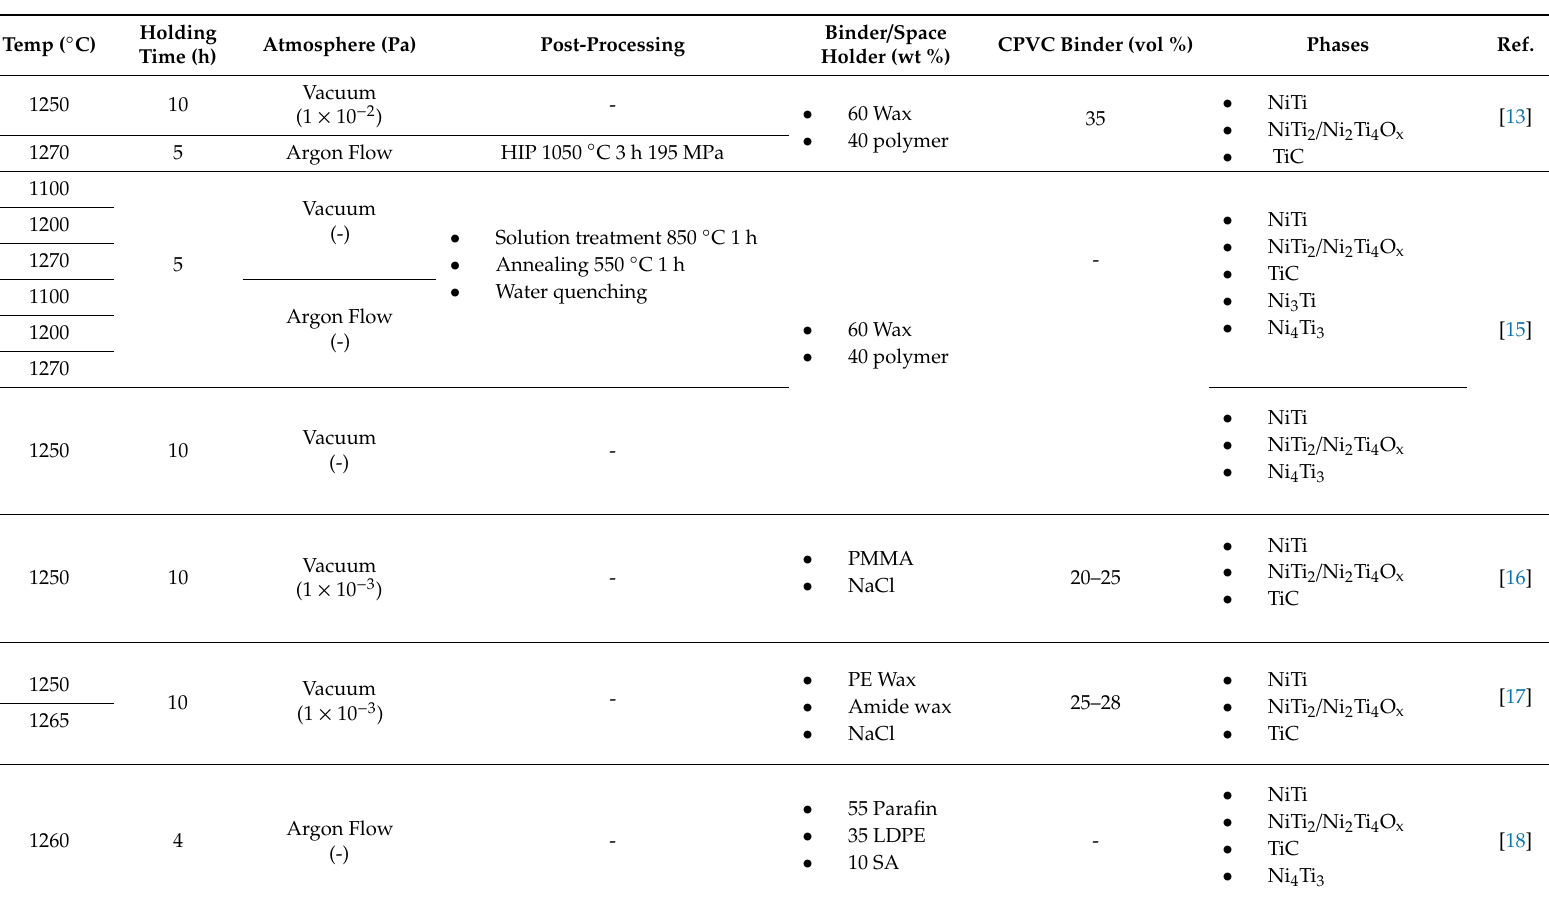
Table 1. Influence of the processing conditions of prealloyed NiTi powders on the final phase composition (shaping = powder injection moulding (PIM)). Temp ( ◦